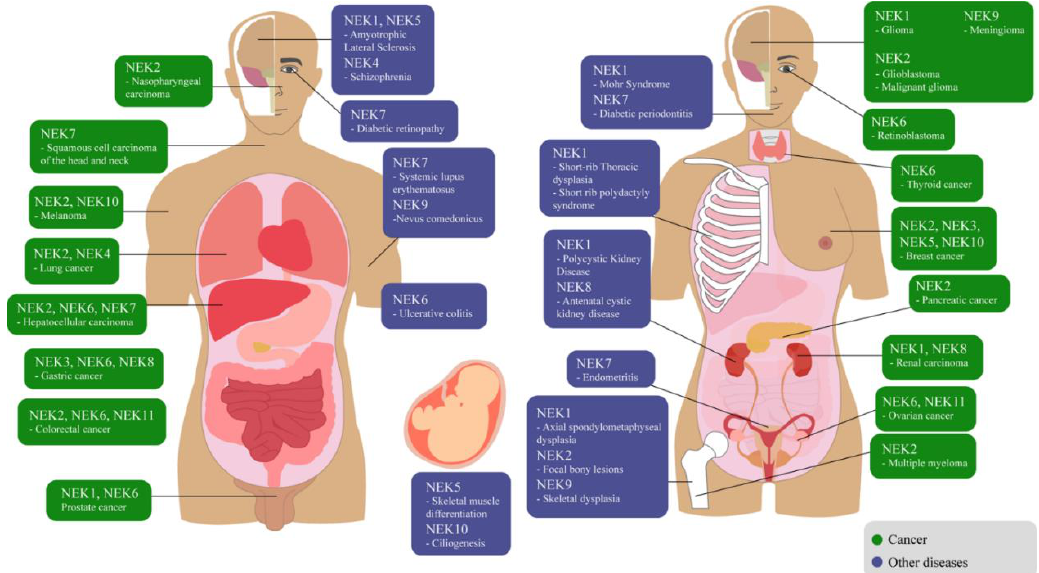
Figure 3. Schematic overview of NEKs and human diseases. At the top left, a human embryo is represented. It shows the relevance of NEK5 and NEK10 in the development of some tissues. In the middle, the correlations between NEKs and human diseases are presented, for each corresponding organ. There are no major differences between men and women, except for the reproductive organs and breasts. For schematic purposes, the figure only highlights some organs for each sex.